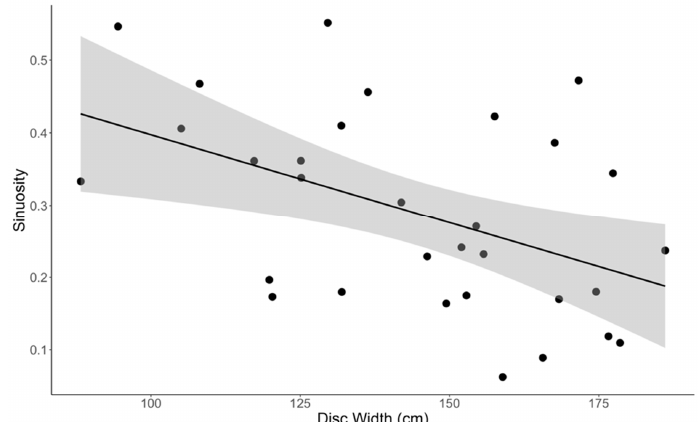
Figure 7. Scatter plot of the sinuosity of each track plotted against the disc width of each ray. The line represents the line of best fit (R 2 = 0.195, F 1,29 = 8.265, p = 0.008) with the shaded area representing 95% confidence intervals.